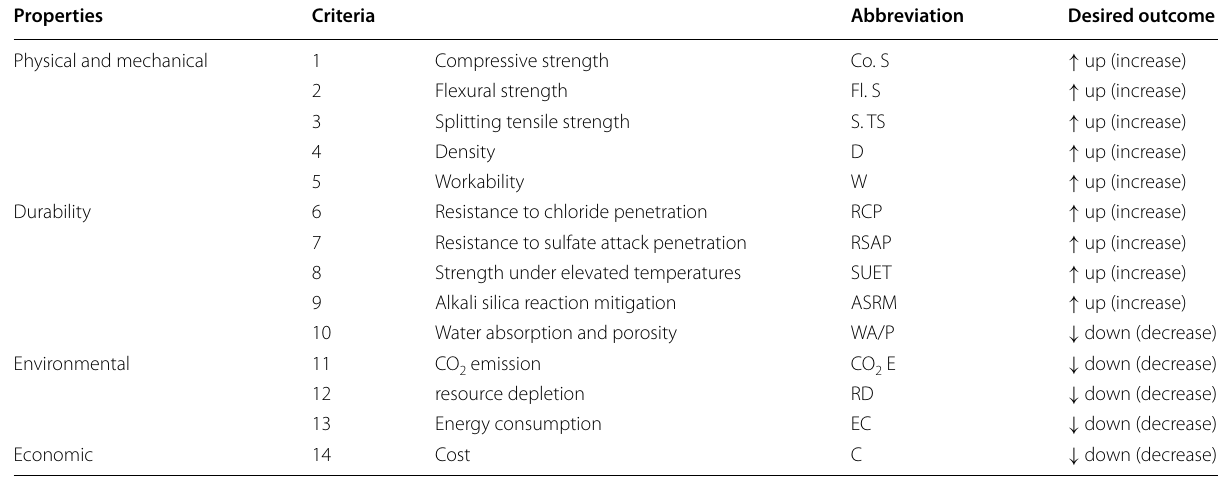
Table 2 Concrete characteristics (criteria).